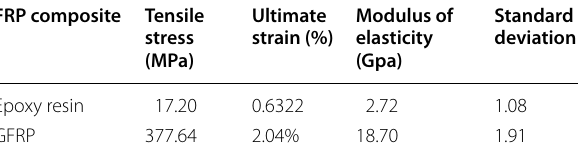
Table 4 Mechanical properties of epoxy resin and GFRP composite.